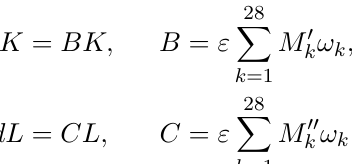
, r , r ) , while for 1 2 3 , r , r ) . We do not know how 1 2 4